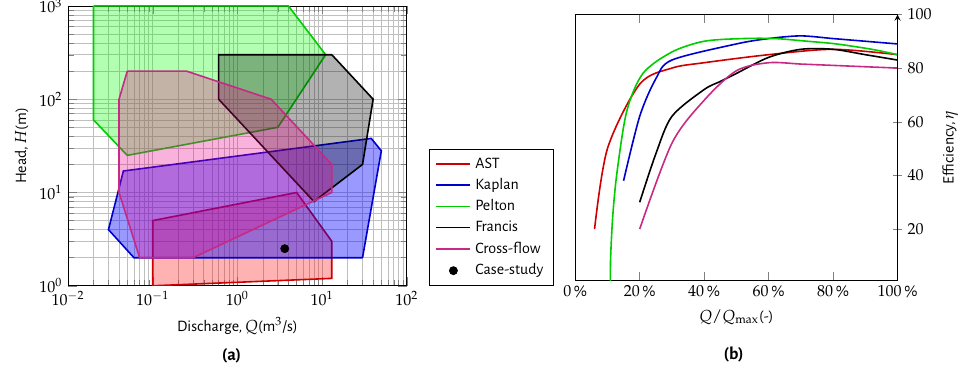
Figure2. (a)Turbinerangeofoperation;and(b)turbineefficiencycurves(adaptedfrom[30]) Figure 2. ( a ) Turbine range of operation; and ( b ) turbine efficiency curves (adapted from